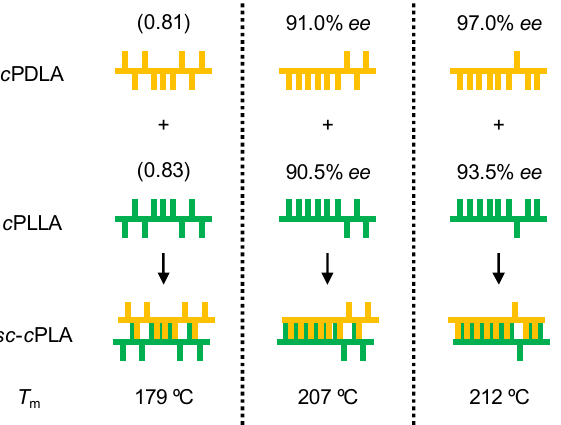
Figure 3. Effect of stereochemical purity on the intermolecular interactions in the stereocomplex formation.